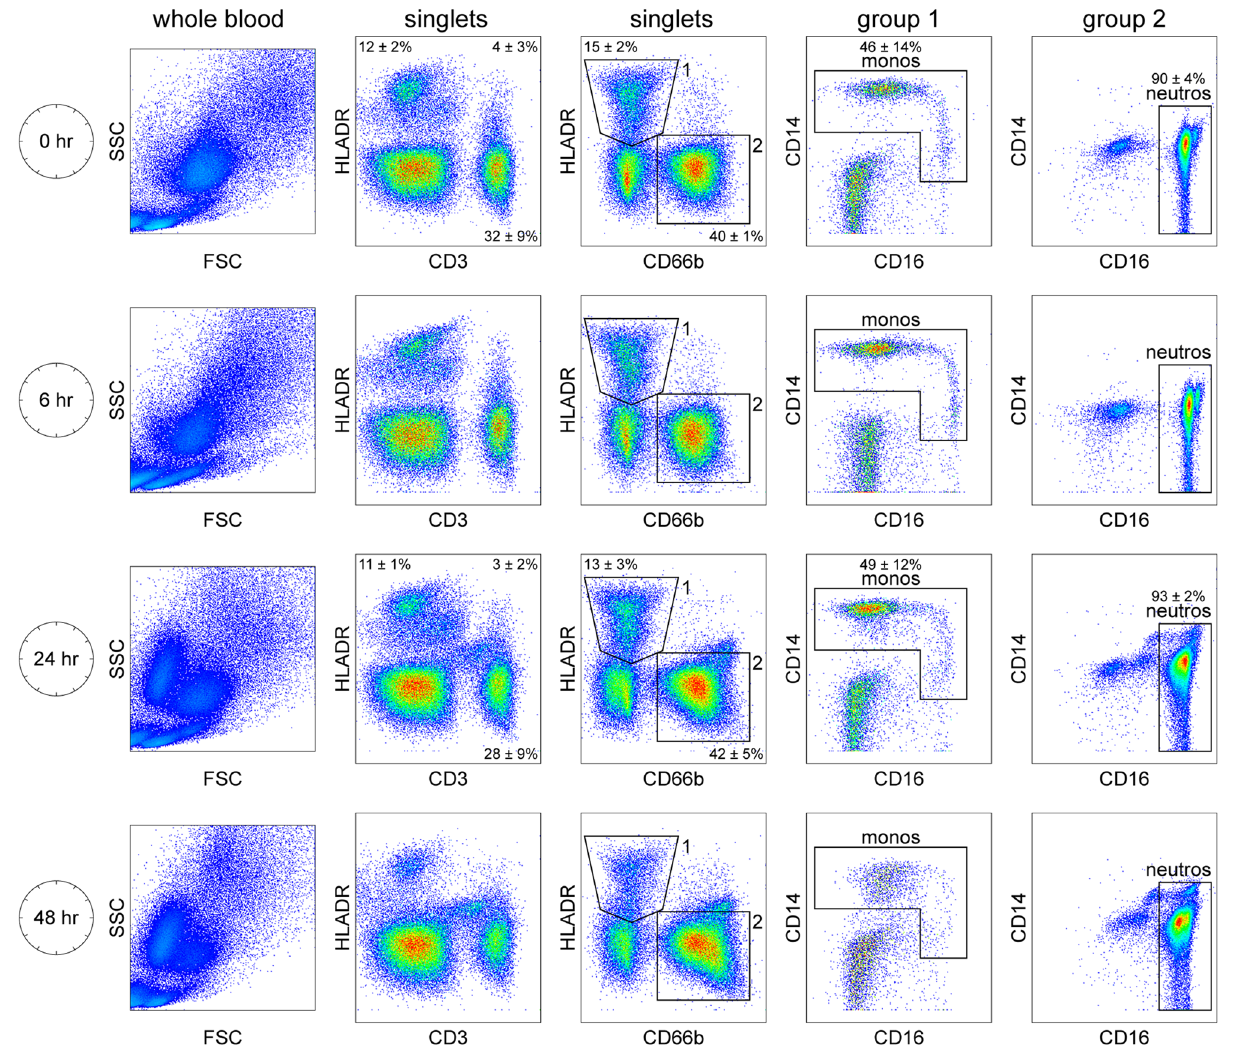
Figure 1. Leukocyte counts and immunophenotype are maintained after overnight (24 h) shipping. Whole blood collected in EDTA tubes was either processed immediately after venipuncture (0 h) or was held for 6, 24, or 48 h at ambient temperature under conditions that modeled courier shipping. At endpoint whole blood was labeled with antibodies against HLADR, CD3, CD66b, CD14, and CD16, followed by red blood cell lysis and brief fixation. Flow cytometric analysis of scatter profile revealed that by 24 h the granulocyte population (FSC hi SSC hi ) had split into two clusters. Singlets were identified based on FSC area x FSC height and all subsequent analyses were performed on total singlets without further gating. The overall pattern and density of HLADR + or CD3 + cells was maintained through 24 h. Likewise, HLADR + CD66b - (group 1) and HLADR - CD66b + (group 2) populations were largely maintained. HLADR + CD66b - cells were further gated on CD14 and CD16 to reveal monocytes (monos), broadly defined as CD14 + CD16 lo/neg classical monocytes, CD14 lo CD16 + non-classical monocytes, and CD14 +/mid CD16 + inflammatory monocytes. HLADR - CD66b + cells were largely comprised of CD16 ++ CD14 lo/neg neutrophils (neutros). Percents for relevant populations are shown at 0 h and 24 h derived from 4 subjects (mean ± 95%CI); 6 h and 48 h show representative tion, frequently require separation of mononuclear cells (such as lymphocytes, monocytes, dendritic cells) from polymorphonuclear cells (such as neutrophils, eosinophils). In broad terms, gradient centrifugation through a medium with a density of 1.077 g/mL cleanly separates mononuclear and polymorphonuclear cells 12,13 . Using this process with whole blood also yields acellular plasma. In parallel, purification of neutrophils, per se, is readily accomplished by immunomagnetic selection of whole blood. The plasma fraction, representing factors that were present in circulation at the time of collection plus any additional factors released by cells during the shipping period, showed only limited evidence of either large increases or decreases in all of the cytokines and chemokines analyzed (Table 2). In order to control for marked differences in concentrations between analytes, each measurement was recast as percent of the mean of the 0 h plasma value per analyte. Two-way ANOVA for all 10 inflammatory factors revealed a significant change through time (F (3,160) = 10.50, P < 0.0001), though time (vs analyte) only accounted for 8% of the total variance. Dunnett’s pairwise comparisons through time for each